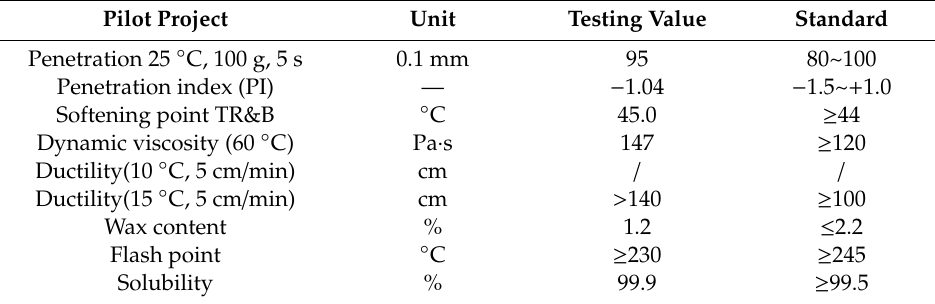
Table 3. Technical indices of 90 ordinary hot asphalt.